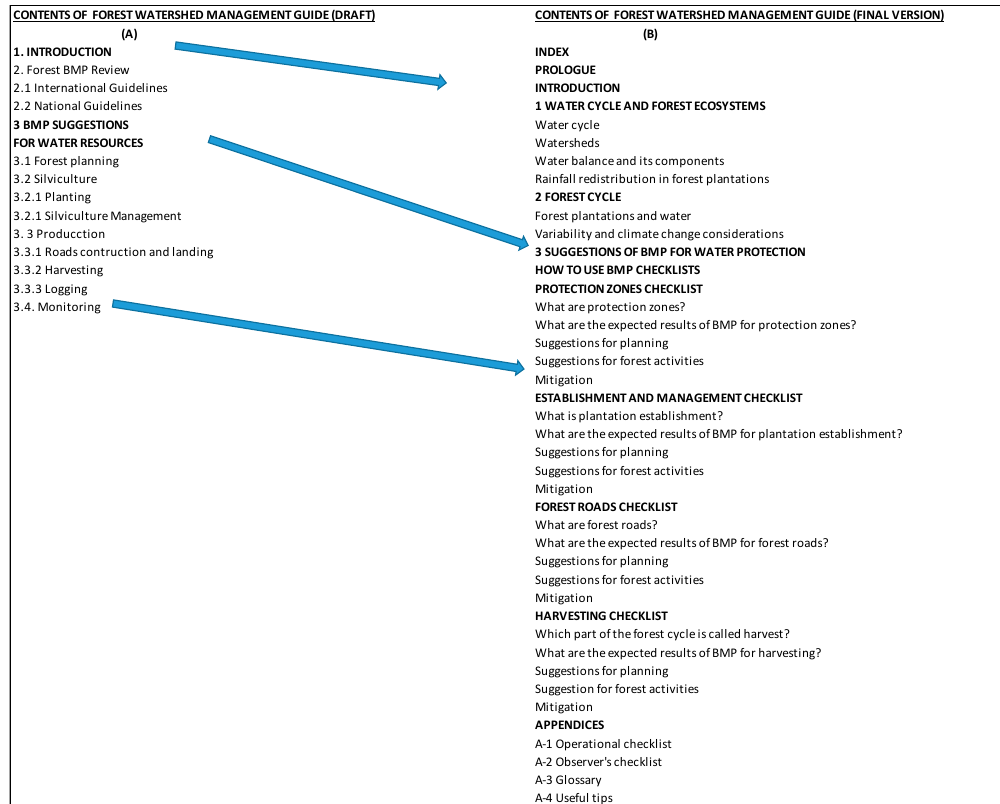
Figure 3. Changes in the forest watershed management guide after stakeholders’ consultation. Draft Figure3. Changesintheforestwatershedmanagementguideafterstakeholders’consultation. Draft ( A ); ( A ); final version ( B ). BMPs—best management practices. final version ( B ). BMPs—best management